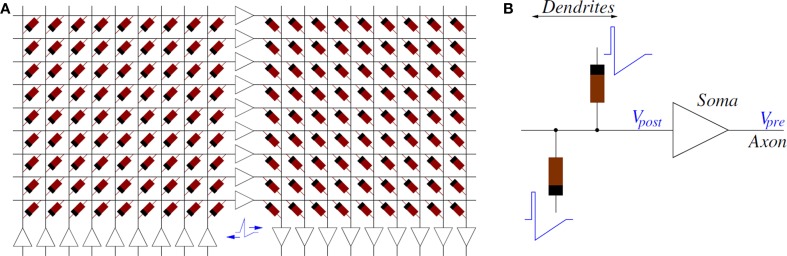
(A) Example of Memristors and CMOS neuron circuits arrangement for achieving STDP learning: feed-forward neural system with 3 layers of neurons and two fully connecting synapse crossbars. (B) Details of parts around one post-synaptic neuron. While a neuron is silent, it sets a constant DC voltage at its input (Vpost) and output (Vpre) nodes. When a neuron is sending a spike, it sets a voltage spike at both nodes.